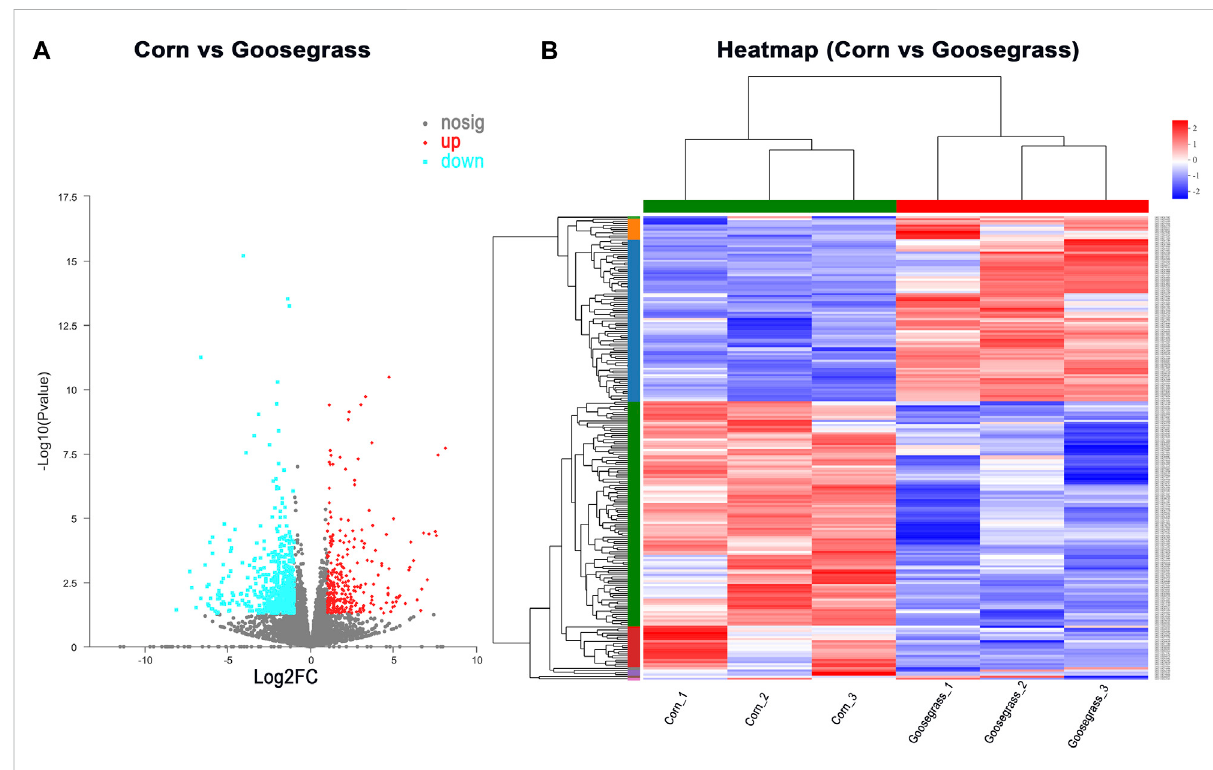
FIGURE 3 Overview of transcriptome data. (A) Volcano plot and (B) heatmap for all obtained